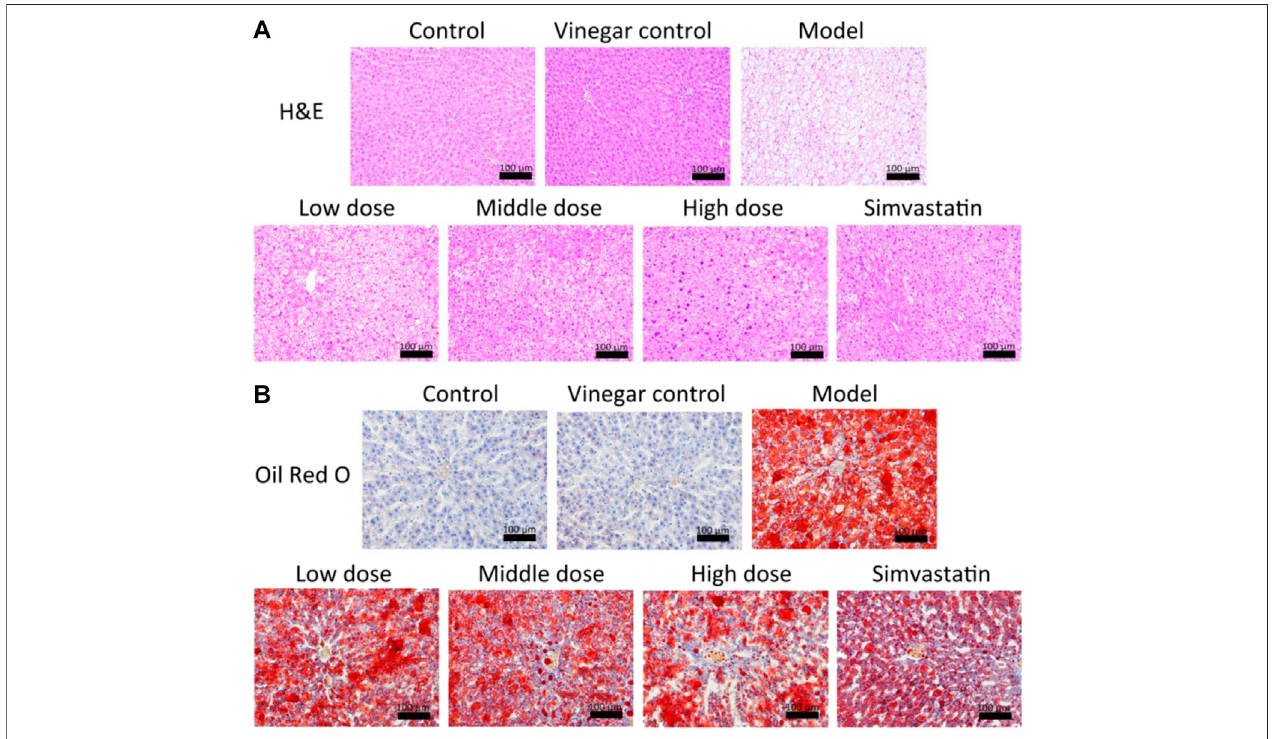
FIGURE 3 | Effects of aromatic vinegar against non-alcoholic fatty liver disease in rats based on staining. (A) Effects of aromatic vinegar on HE staining images of liver tissues in rats ( × 200 magni fi cation); (B) Effects of aromatic vinegar on Oil Red O staining images of liver tissues in rats ( × 200 magni fi cation). Scale bar (cid:2) 100 µm. Values are expressed as the mean ± SD. * p < 0.05, ** p < 0.01 compared with model